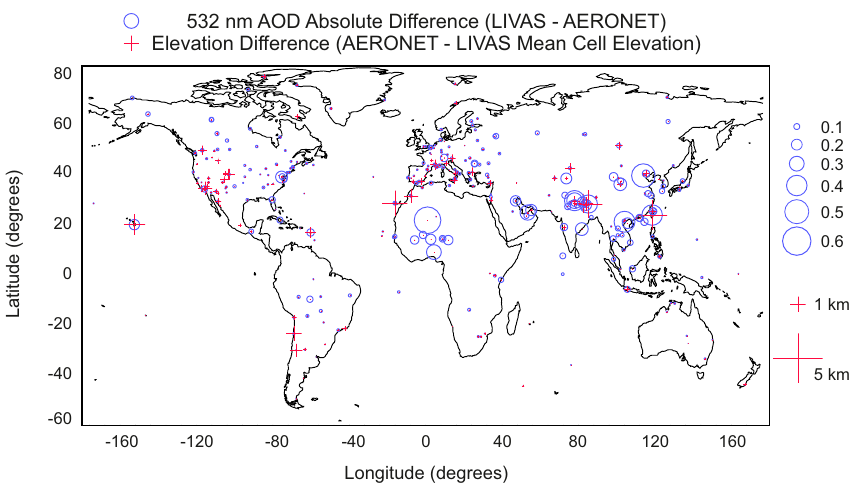
Figure 12. Spatial distribution of the 532nm AOD absolute differences (absolute value of LIVAS averaged AOD minus AERONET averaged AOD) (blue circles) and of the difference between AERONET site elevation and mean grid cell elevation of CALIPSO overpasses (red crosses).